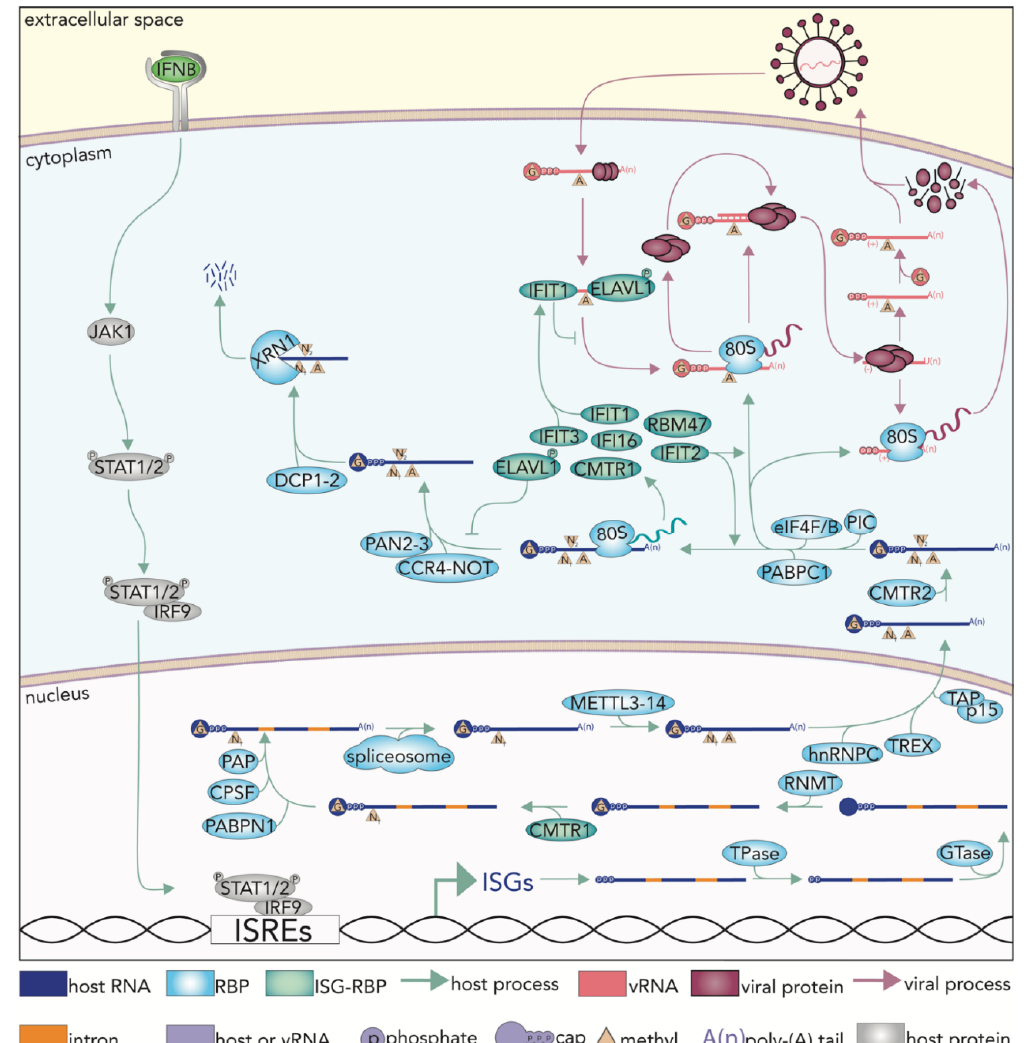
Figure 2. Immune stimulation and viral infection lead to a tension between host and pathogen for control of cellular RBPs, RNA metabolic processes, and gene expression. IFNB induces a JAK/STAT signal transduction event culminating in activation of IRF9 and its association with IFN stimulated response elements (ISREs) within the promoters of interferon stimulated genes (ISGs) [1–3]. RBPs facilitate all aspects of RNA metabolism including mRNA maturation, initiation of translation, and stability–processes which are also subject to hijacking by viral pathways. Capping and polyadenylation of mRNAs are an important step in transcript maturation and are facilitated by nuclear-localized RBPs; see text for additional details. Once a transcript is fully matured, it is exported out of the nucleus typically via the TREX complex where it can encounter additional RNA modifications; for example, methylation of the second transcribed base by CMTR2. The formation of a competent PIC is a limiting step to translation initiation and recruitment of the 80S ribosomal subunit. RNA stability in the cytoplasm can be influenced by a number of factors including the association of PAN2/3 and CCR4-NOT which leads to deadenylation, decapping (DCP1/2) and eventual degradation by XRN1. In nearly all cases, there exist viral mechanisms that can usurp control of RNA processes for their own purposes. Thus, the existence and levels of select host RBPs can impact the efficiency of viral replication. Existing and newly expressed RBPs, as a result of innate immune activation (ISG-RBPs), are collectively responsible for managing host gene expression, but also in the surveillance and clearance of pathogenic RNA. INTERFERON INDUCED PROTEIN WITH TETRATRICOPEPTIDE REPEATS 1 (IFIT1) heterodimerizes with IFIT3 and binds incompletely capped RNA to prevents translation of that RNA. IFIT2 is associated with an increase in ISG and vRNA translation [53]. Constitutively expressed protein, EMBRYONIC LETHAL VISION-LIKE PROTEIN 1 (ELAVL1), is phosphorylated during immune stimulation and primarily localizes to the cytoplasm where it binds the 3 (cid:48) UTR of ISGs to stabilize them. ELAVL1, IFI16, and FASN, which can all bind cellular RNA, also bind CHIKV